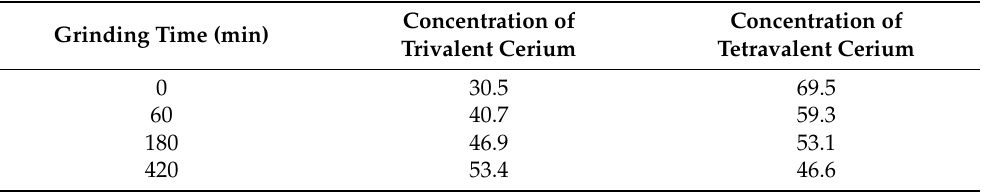
Table 6. Concentration of tri- and tetravalent cerium in the samples by grinding with microwave irradiation, based on X-ray absorption near-edge structure analysis in the cerium K-edge (%).